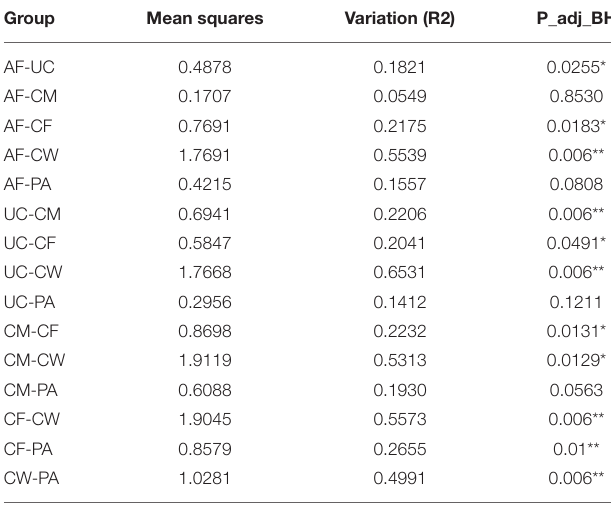
TABLE 4 | PERMANOVA assessment of differences in bacterial community structure between two groups by Adonis.